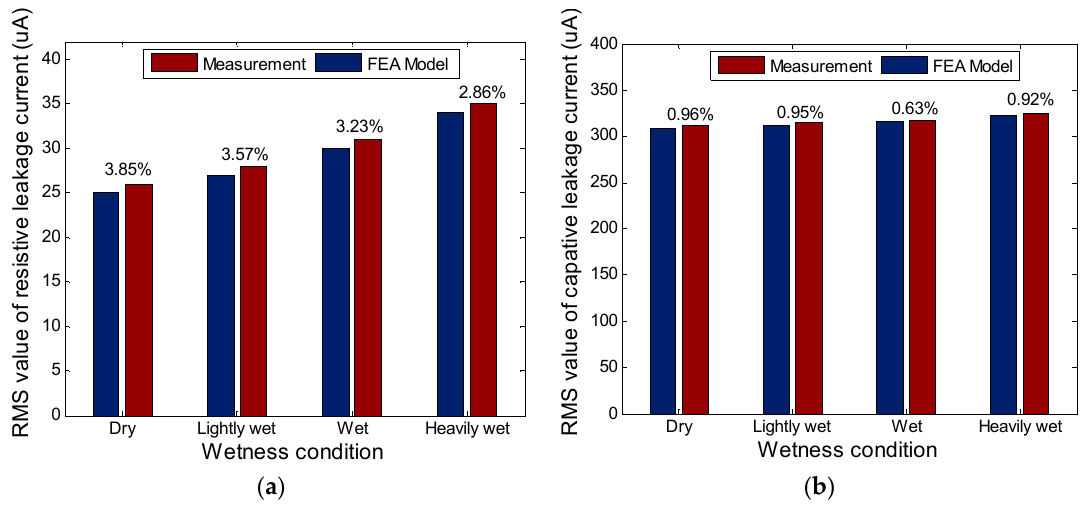
Figure 10. RMS value of the leakage current between measurement and FEA model under different wetness conditions at 8 kV rms for ( a ) resistive; ( b ) capacitive leakage current.